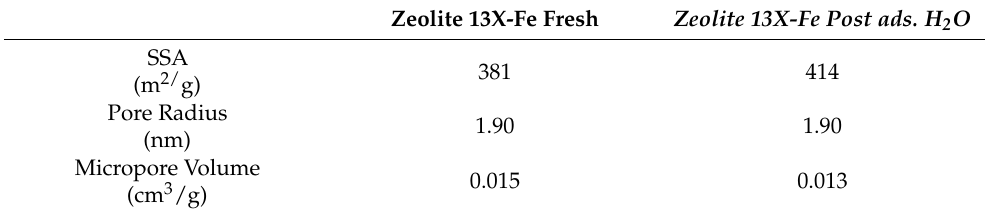
Figure 9. Adsorption isotherms of fresh and post wet adsorption pink samples. Table 5. Results of adsorption–desorption of N 2 (77